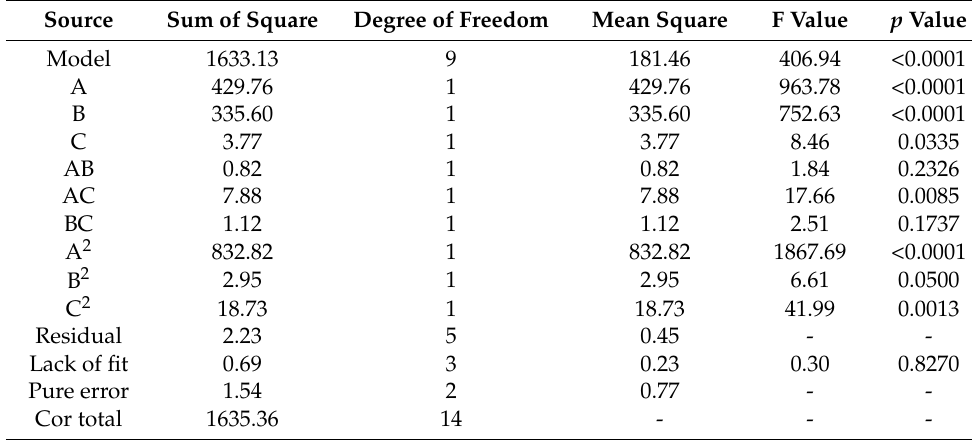
Table 9. Analysis of variance for the Box–Behnken